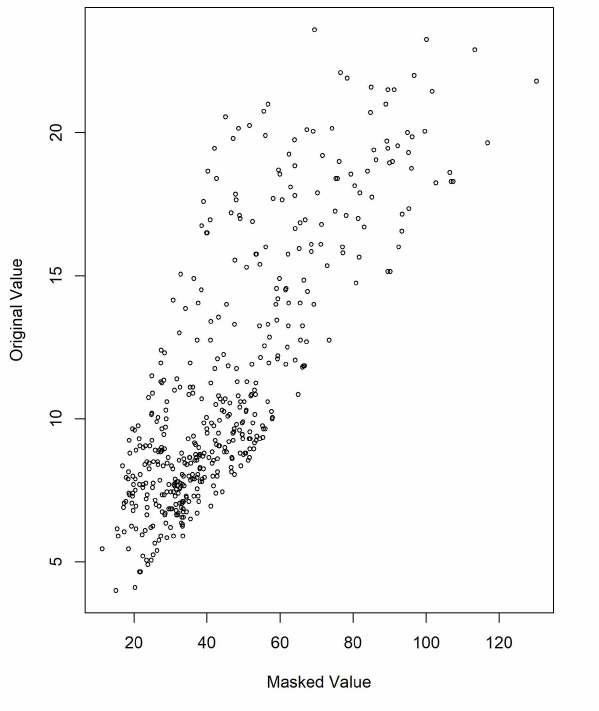
Figure 4. The scatter plot of the masked values and the original values for seed size.